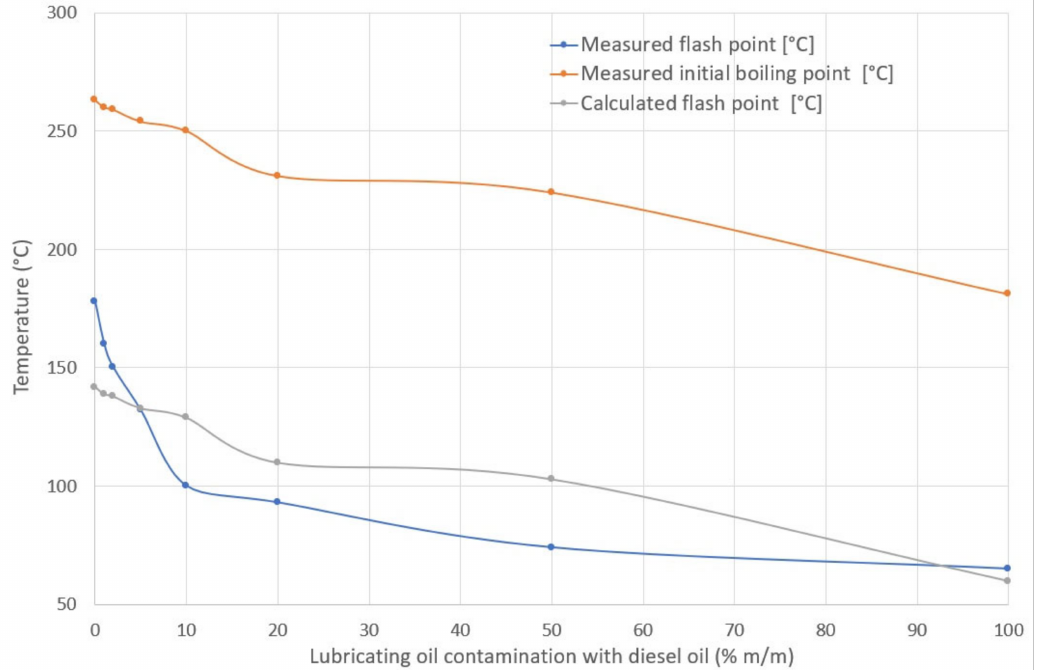
Figure 3. Measured values of the initial boiling point and the flash point and the calculated flash point of the tested SAE 40 oil at different levels of lubricating oil dilution with diesel